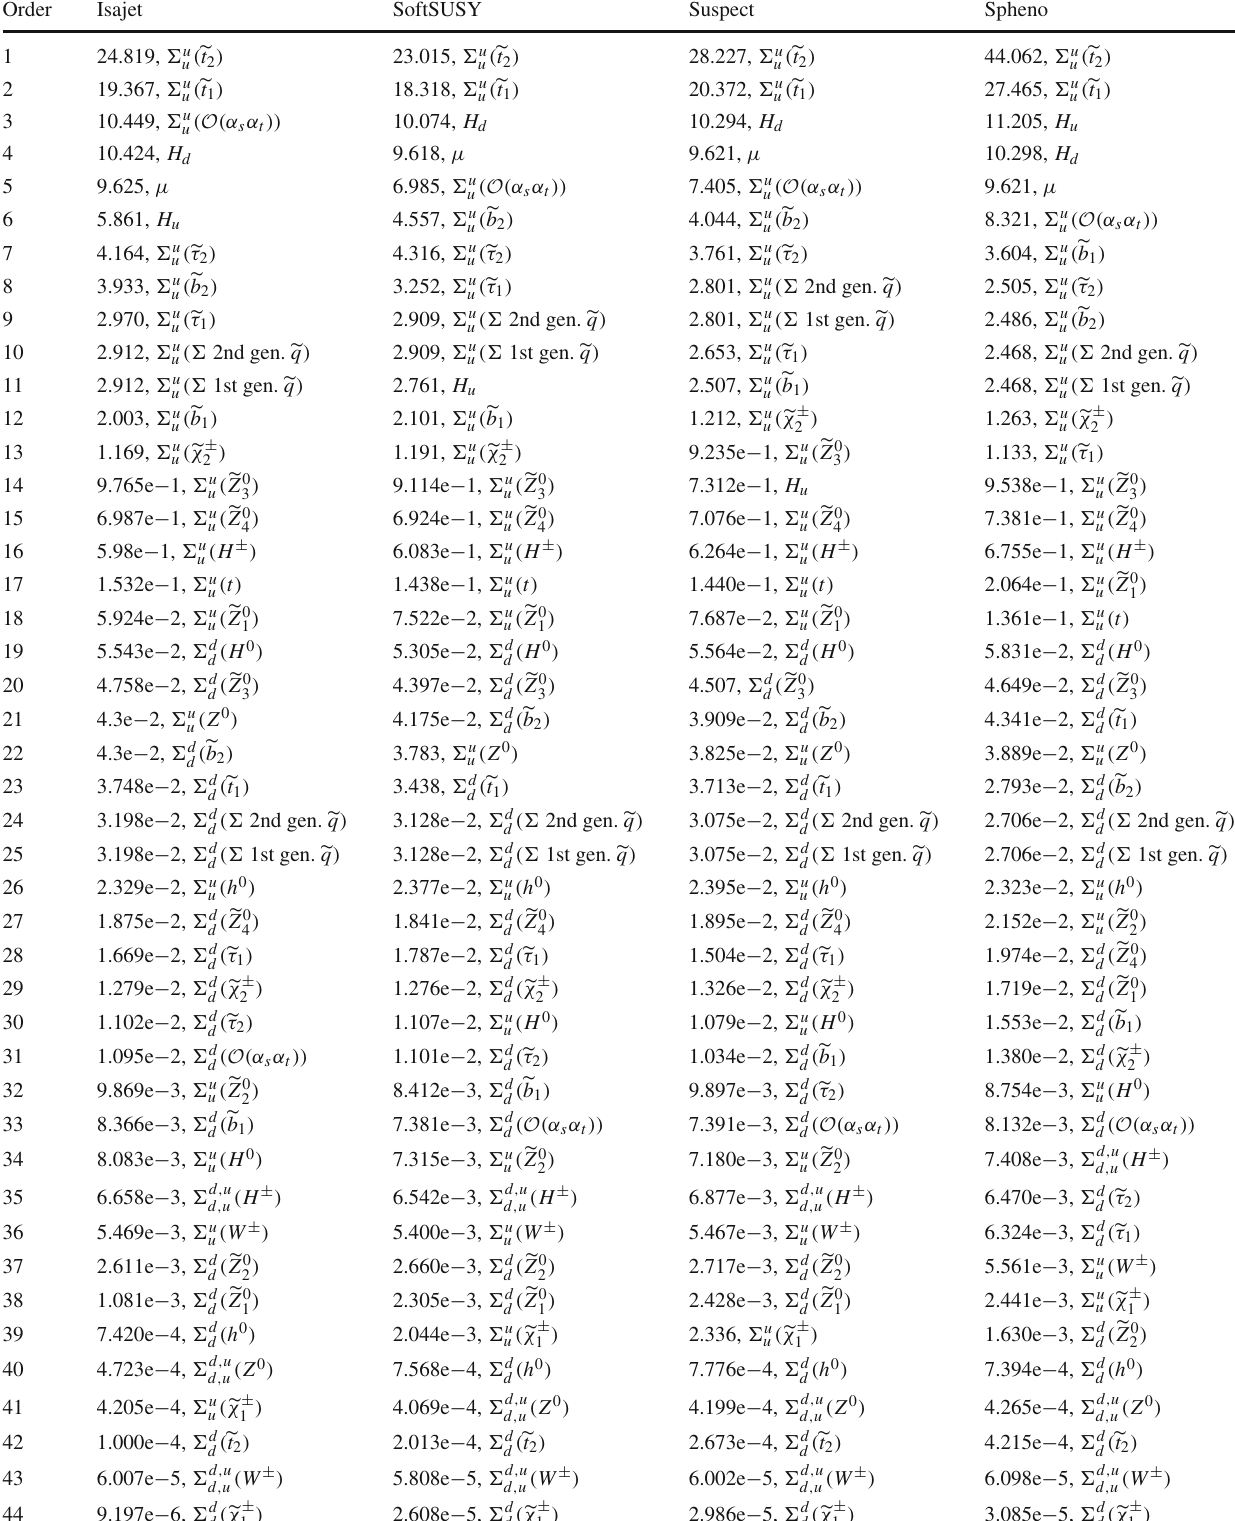
Table 2 Top 46 contributions to (cid:2) EW for our natural SUSY benchmark point for four different spectra calculator codes